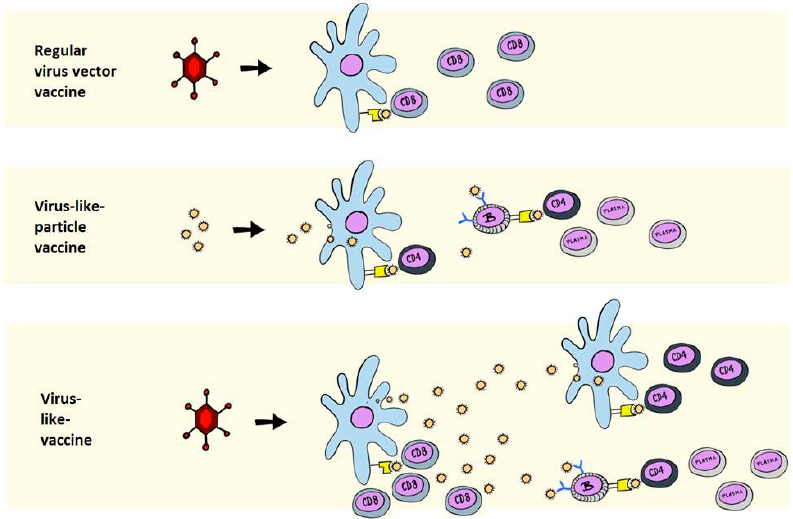
Figure 1. Primary immunological mechanisms of virus vectored-, VLP-, and VLV-induced antigen presentation. The top panel depicts a virus vectored vaccine that encodes an intracellular or non-secreted antigen. The principle manner of antigen presentation is via MHC class I presentation to CD8 + T cells through the direct presentation pathway. The middle panel depicts a classical ex vivo purified and injected VLP vaccine, which can be taken up by antigen-presenting cells to be presented on MHC class II and stimulate CD4 + T cells, and directly stimulates B cells with antigen in the form of VLPs. The bottom panel depicts a VLV, where the antigen is initially synthesized intracellularly for MHC class I presentation, followed by the release of VLPs, which stimulate CD4 + T cells and B cells, as in the middle panel.